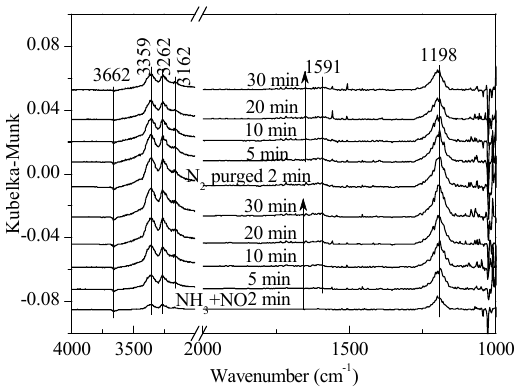
Figure 4. In situ DRIFTS spectra of NH 3 + NO adsorption on 1 wt. % V 2 O 5- 0.2CeO 2 /TiO 2 -ZrO 2 catalysts with N 2 purging for various times at 250 °C after the catalysts were exposed to a flow of 800 ppm NH 3 and 800 ppm NO for 60 min.